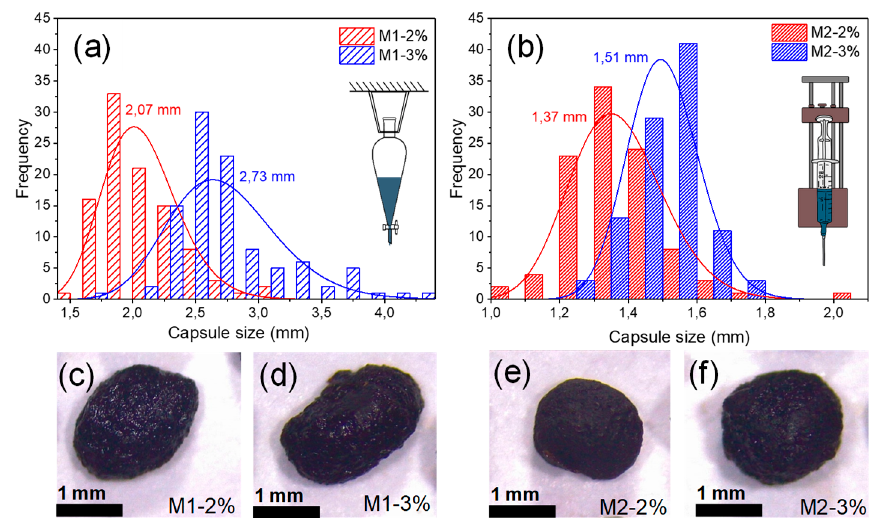
Figure 5. ( a ) Frequency histogram of the size of BO capsules with log-normal fitting produced by the dropping funnel method (M1); ( b ) frequency histogram of the size of BO capsules with log-normal fitting produced by the pressure pump method (M2); ( c – f ) examples of the produced BO capsules.